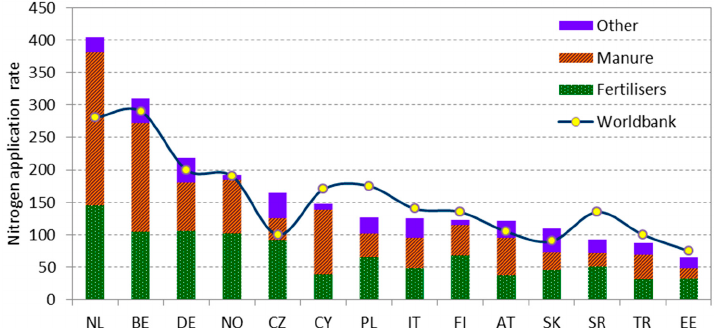
Figure 12. Nitrogen application rates on arable land (in kg ∙ N ∙ ha − 1 ) according to Eurostat [23] and World Bank [24] for the period 2006–2012. Other are soil amendments such as compost, sewage sludge and industrial waste. A two letter code refers to the country that the region belongs to.